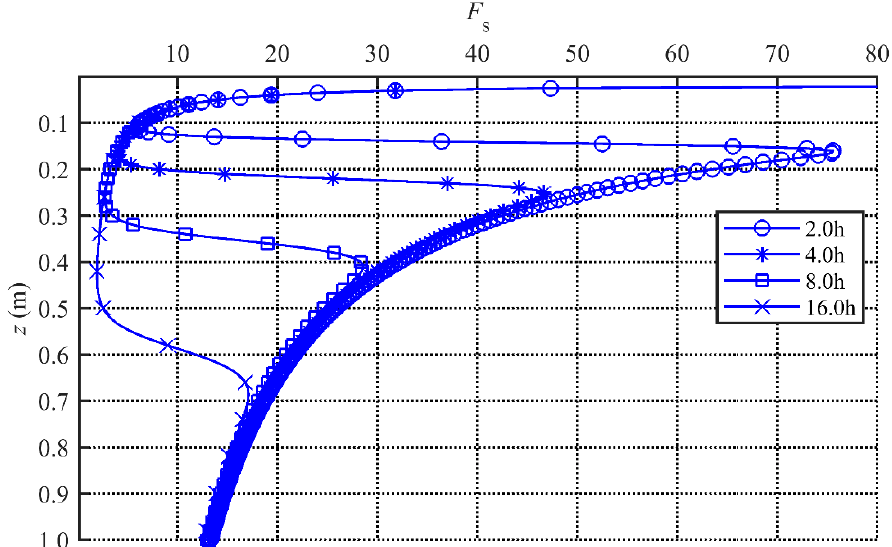
Figure 11. Safety factor profiles at di ff erent times.